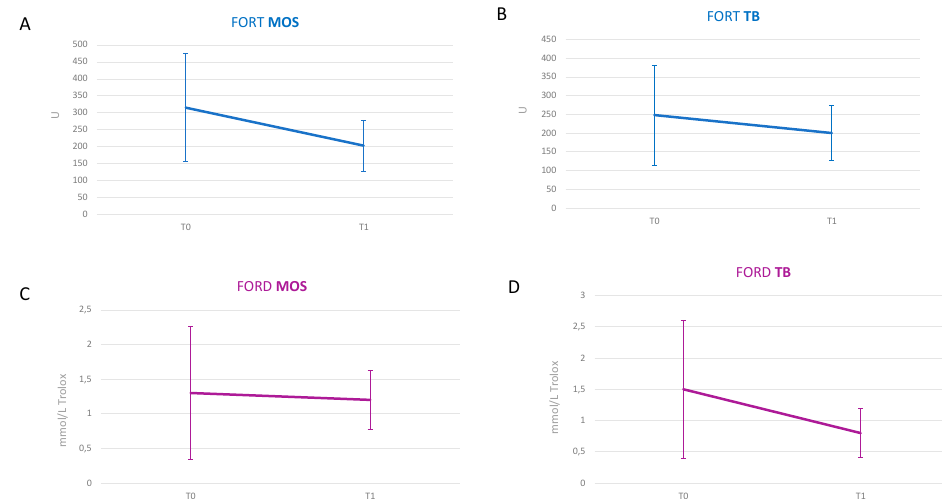
Figure 2. Graphic representation of oxidative parameters in the two time-points of the stud: ( A ) trend of FORT values in patients treated with MOS EVOO, ( B ) trend of FORT values in patients treated with TB EVOO, ( C ) trend of FORD values in patients treated with MOS EVOO, ( D ) trend of FORD values in patients treated with TB EVOO. Abbreviations: EVOO, extra virgin olive oil; FORT, Free Oxygen Radical Test; FORD, Free Oxygen Radical Defense; MOS, Moraiolo (100%); TB, Leccino (33.3%), Moraiolo (33.3%), Frantoio (33.3%). Table 6. Prevenci ó n con Dieta Mediterr á nea (PREDIMED) questionnaire.